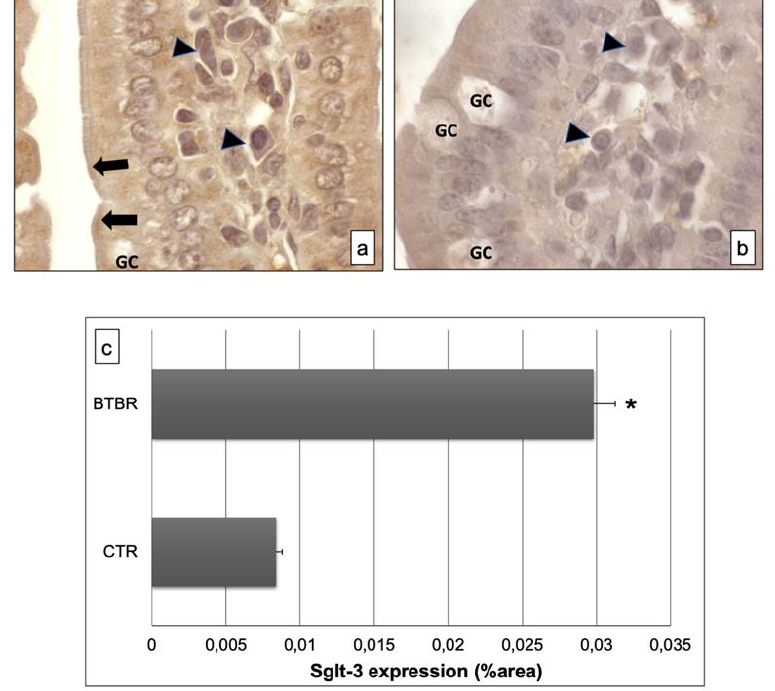
Figure 4. Representative images of Sglt-3 immunostaining in small samples of BTBR and CTR mice (( a , b ) respectively). The immunohistochemical signal (brown) is localized in the intracellular compartment and apical portion (highlighted by black arrows) of small intestine and in some lymphatic cells of the submucosa. ( c ) Statistical analyses of this immunohistochemical technique for intracellular compartment and apical portion of small intestine. Data are presented as mean ± SD. * p < 0.01 vs. CTR mice. Goblet cells are indicated as GC; lymphatic cells (i.e., plasma cells) are indicated with arrowheads in ( a , b ); brush border membrane is indicated as black arrows in ( a , b ).